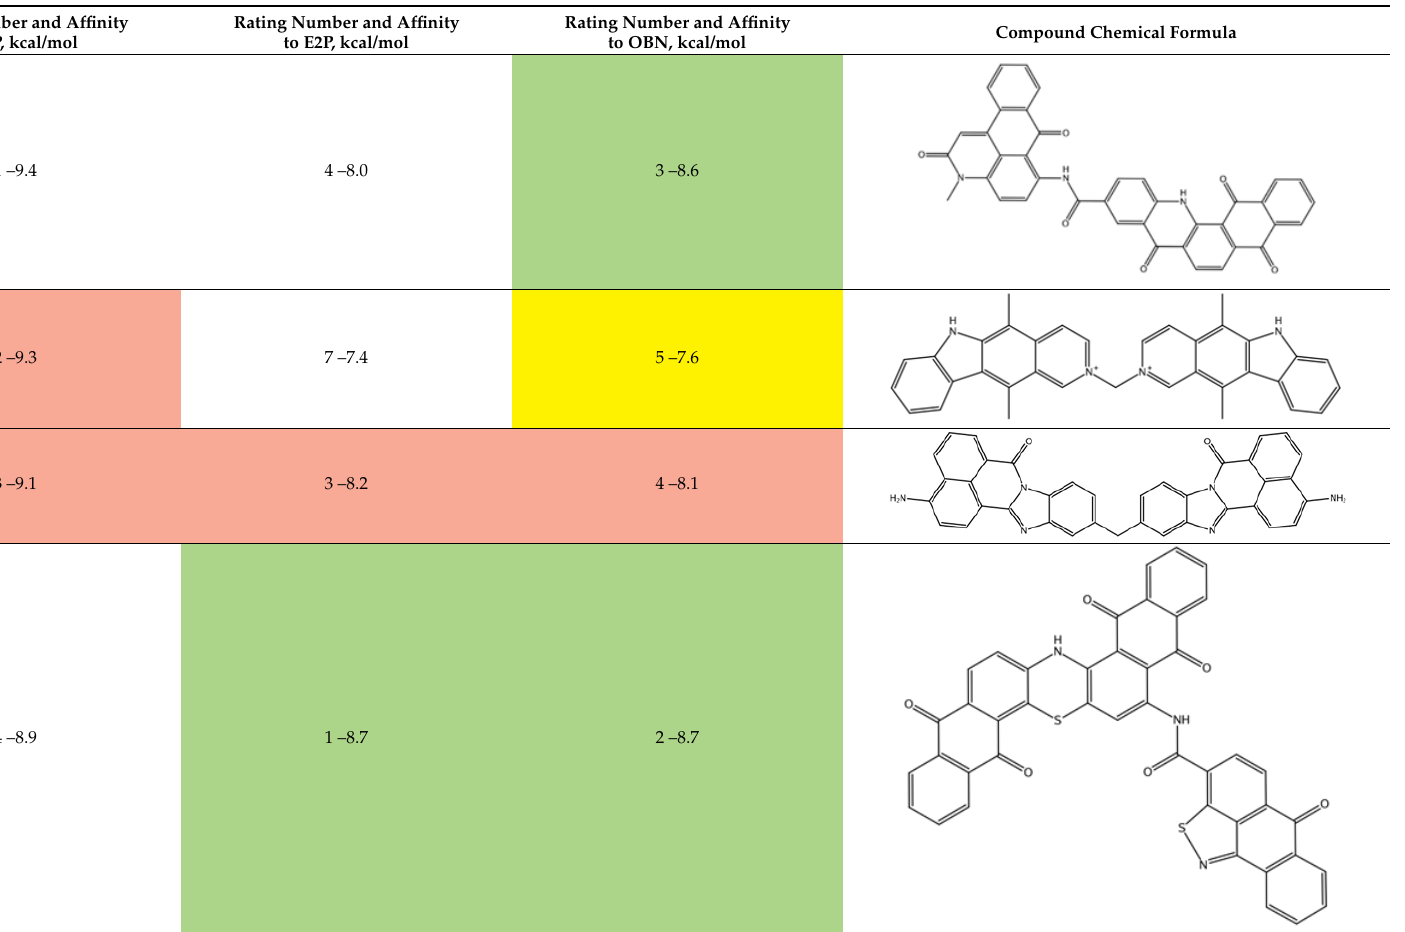
Table 3. List of the top-rated ligands obtained after virtual screening of the complete NCI Open Database using the Autodock Vina program for the Aβ 42 interaction interface with the three Na,K-ATPase conformations. The complexes where the ligands (compounds) remained in the Na,K-ATPase sites forming the interaction interface after MD simulation are highlighted in green. The complexes where the ligands (compounds) entered the Na,K-ATPase cavity after MD simulation are highlighted in yellow. The complexes where the ligands (compounds) moved to the membrane after MD simulation are highlighted in red.